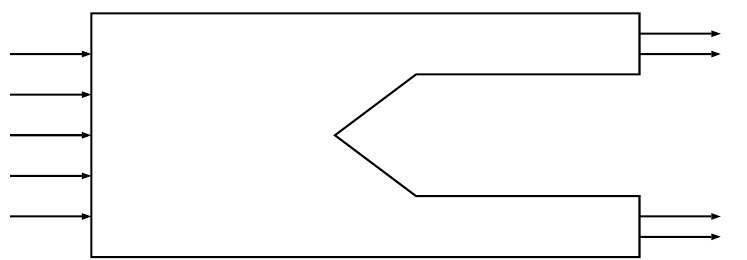
Figure 3. Triangular 2D obstacle